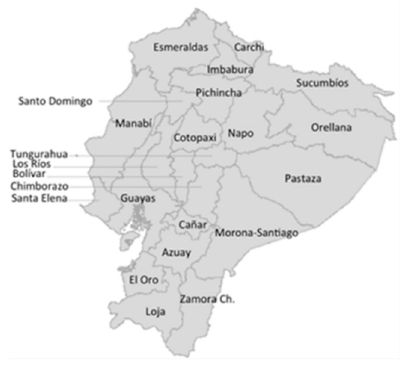
Figure 3. Quantiles of the Sectoral Growth Rate 2007, 2012, and 2017. Source: Own elaboration based on the Regional Accounts of the BCE (2017) [46], and ENEMDU Surveys from the INEC [47] (several years).